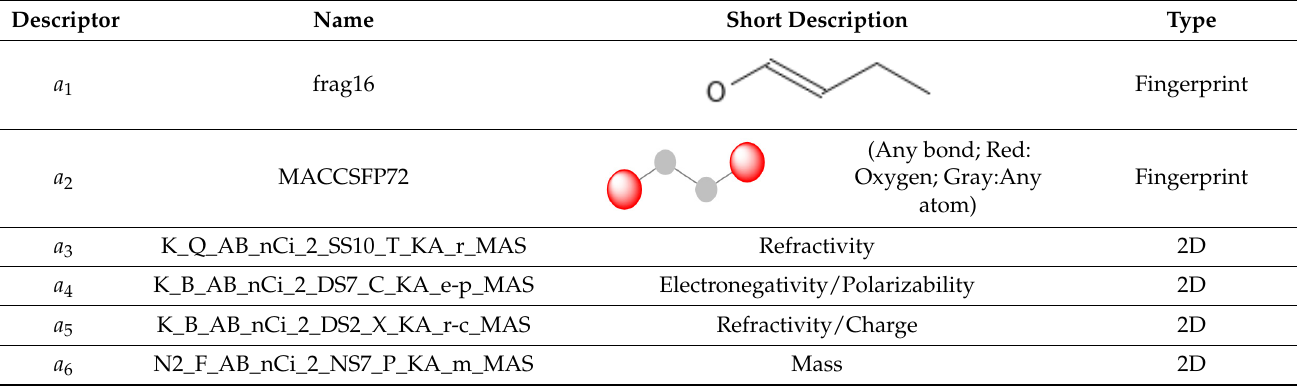
Table 1. Molecular descriptors of the best anti-chagas QSAR model as defined by Equation (1).